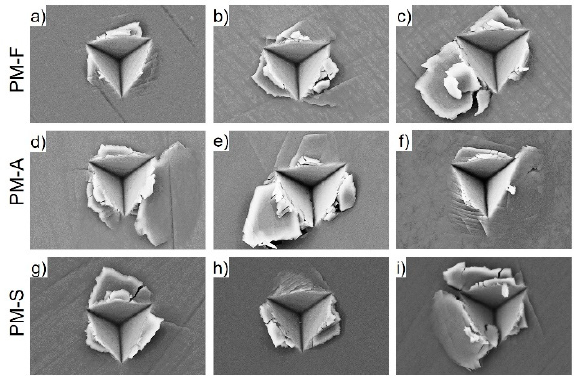
Figure 8. Secondary electron images of the indents made on SFCA crystals: PM-F: ( a ), ( b ), and ( c ); PM-A ( d ), ( e ), and ( f ); PM-S: ( g ), ( h ), and ( i ). Width of each image is 5.405 µm.